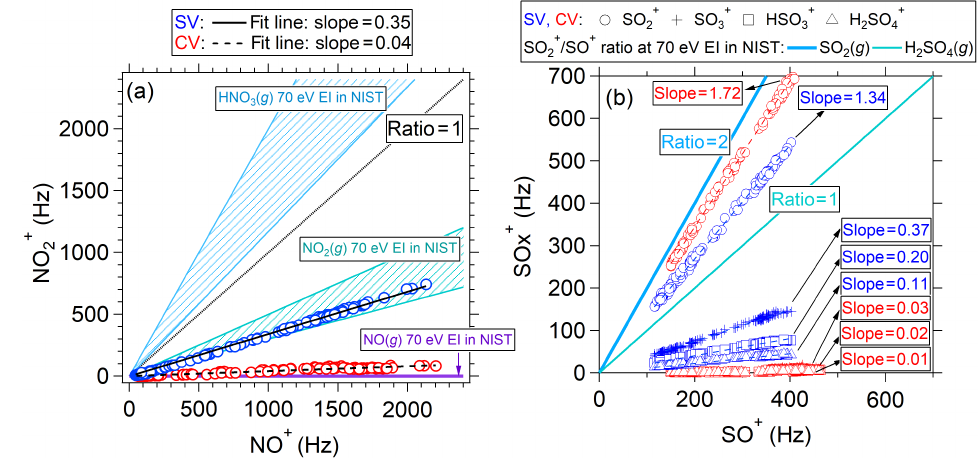
/ SO + ratios 2 , SO + , HSO + and H 2 SO + . 2 3 3 4